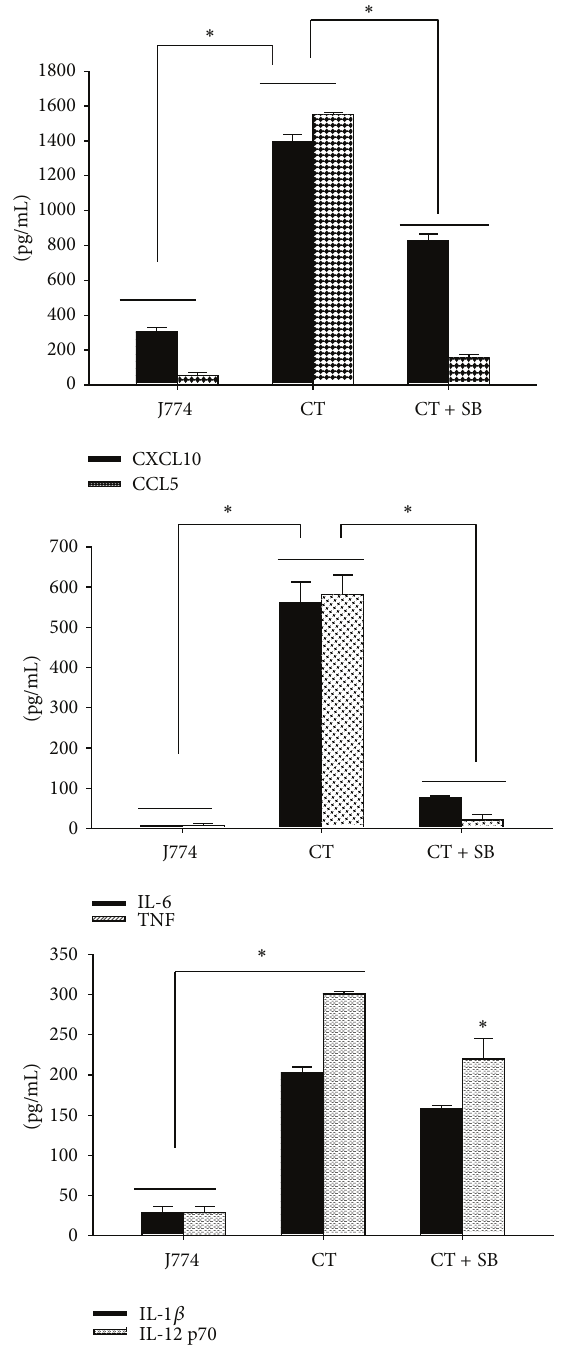
Figure 5: C. trachomatis employs the p38 MAPK pathway for production of inflammatory mediators in mouse J774 macrophages. Macrophages (10 6 cells/mL) were seeded in 24-well plates in the presence and absence of the SB-203358 p38 inhibitor for 24h, after which they were left uninfected or infected with live C. trachomatis (10 5 IFU/mL). After 3 days following infection with C. trachomatis (CT), supernatants were collected and the levels of inflammatory mediators were determined by single ELISAs. ∗ 𝑃 < 0.05 is considered significant when compared to untreated cells (J774) and to cells treated with CT or CT + SB. Data shown is an average of duplicate run representative of two separate experiments.